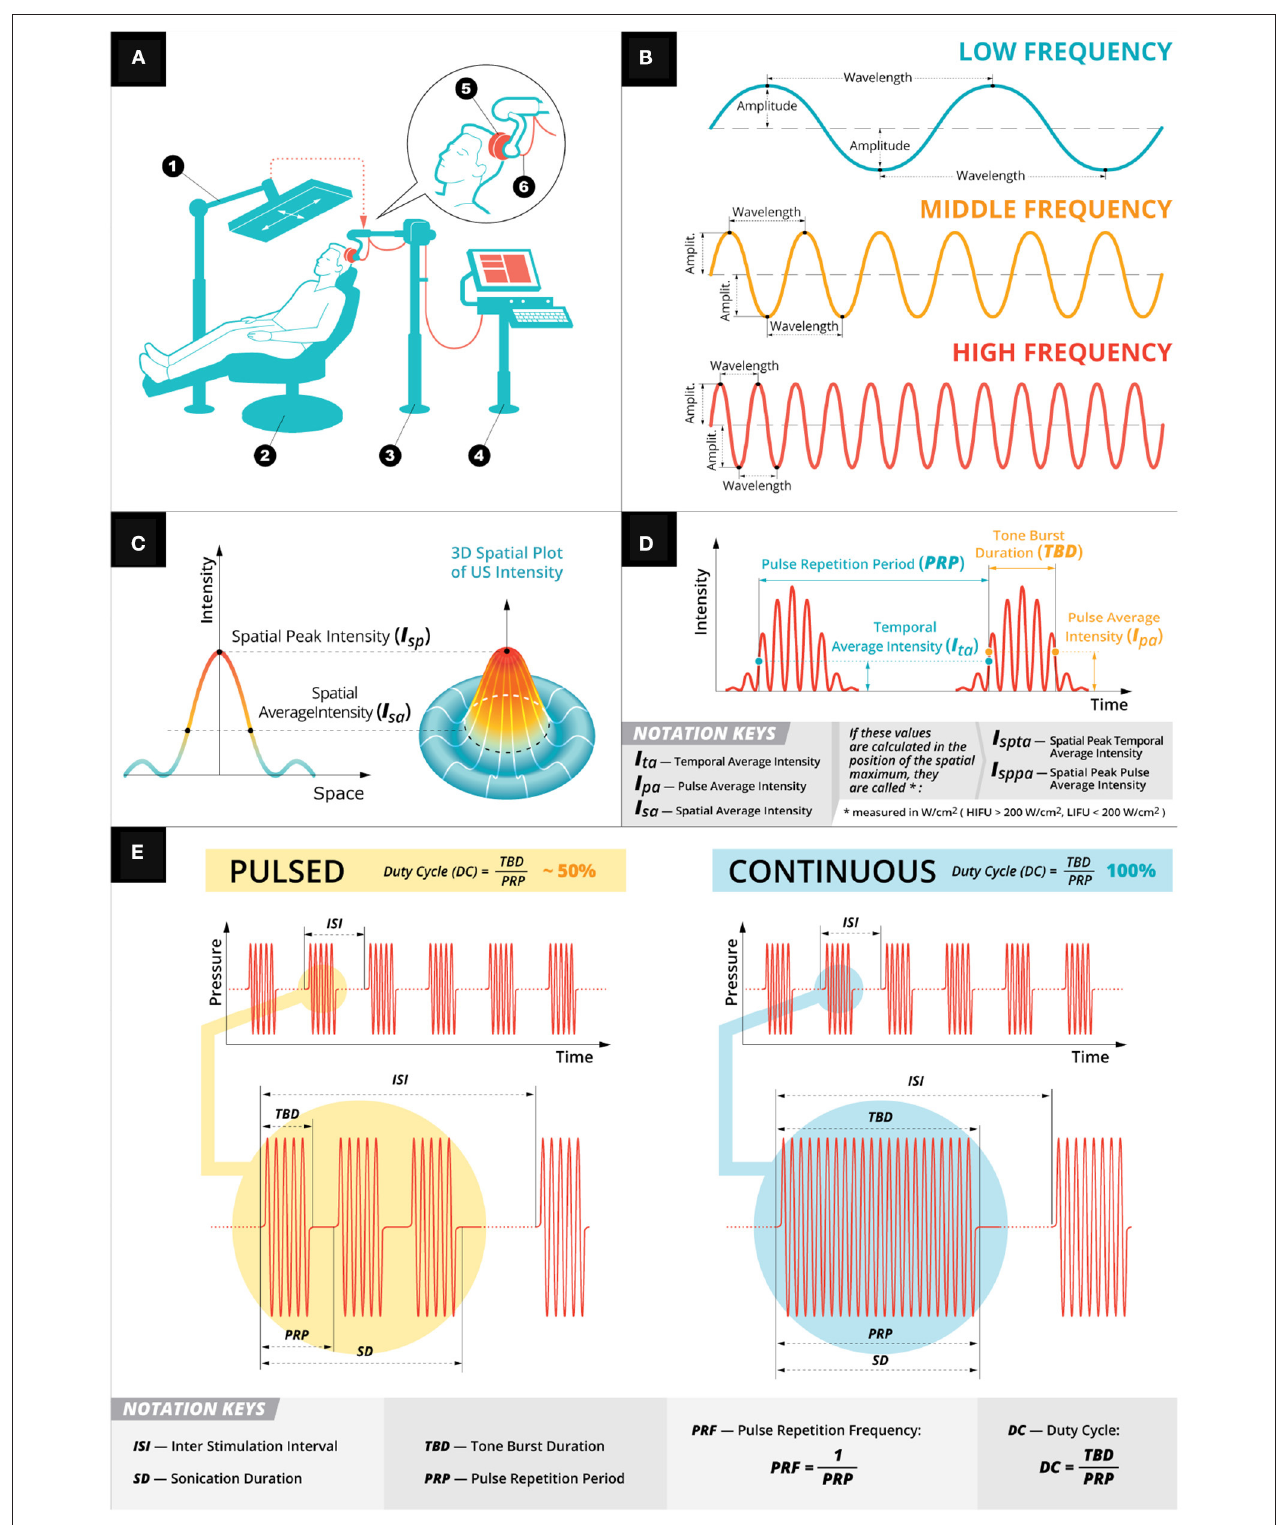
FIGURE 1 | Low intensity focused ultrasound general principles. (A) A depiction of a typical LIFU experimental setup. A participant is seated (2) with an US device (5) firmly pressed against their head held in place by an arm (3). The US device is controlled by a computer system (4) and targeted using infrared system